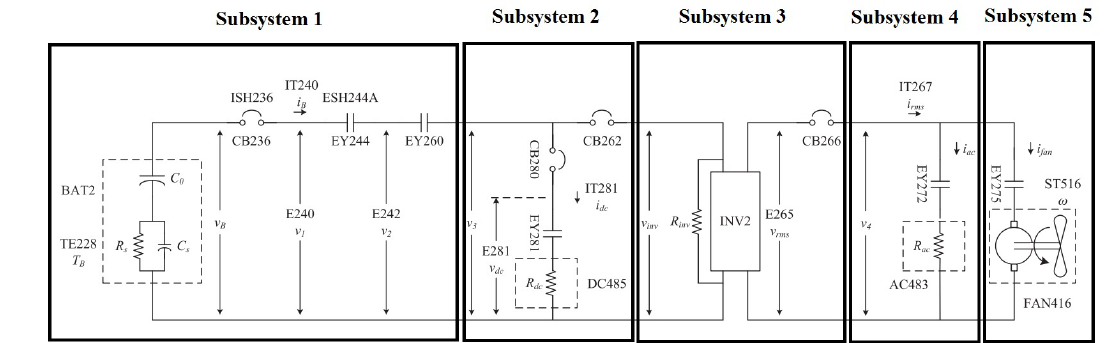
Figure 11. ADAPT-Lite subsystems [30]. CB, Circuit